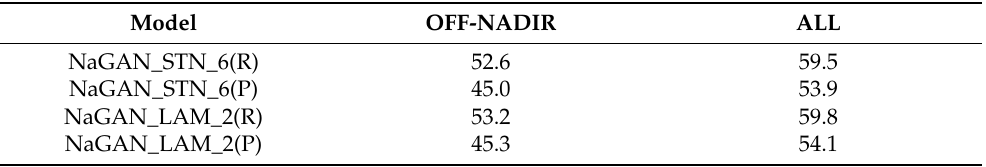
Table 4. Performance comparison on NaGAN with STN or with the label alignment. (R): AR@0.5,